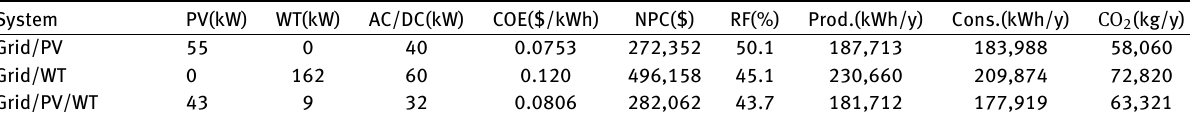
Table 6: Optimization results of grid-connected HRES systems for Sattam